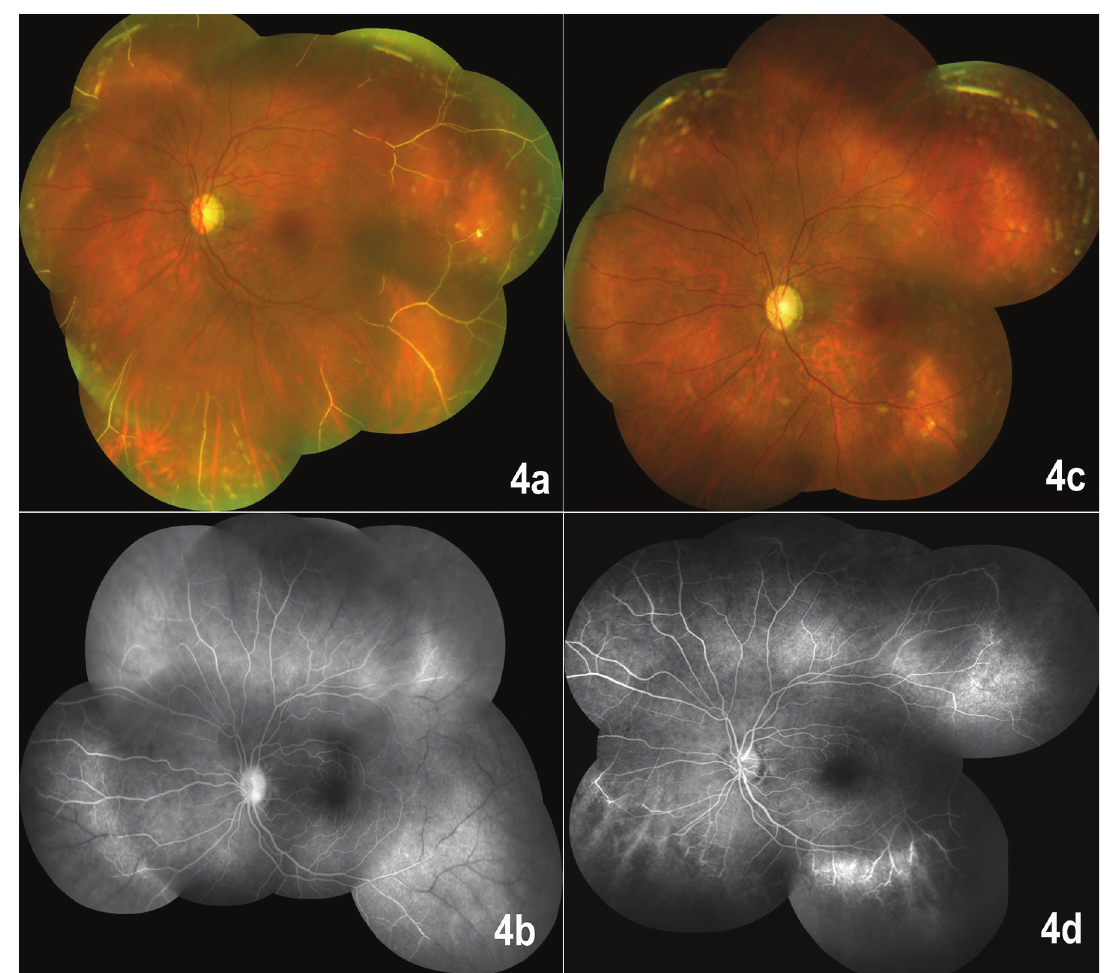
Figure 4. a. Colour fundus photograph of the left eye at 2 weeks follow up documents fragmentation of blood column into aggregations of erythrocytes in occluded network of vessels. b. Fluorescein angiography of the left eye at 2 weeks follow up outlines largely occluded peripheral vessels. c. Colour fundus photograph of the left eye at 4 months showing attenuation of previously occluded vessels. d. Fluorescein angiography of the left eye at 4 months follow up shows arterio-venous shunt and microaneurysms compensatory changes.